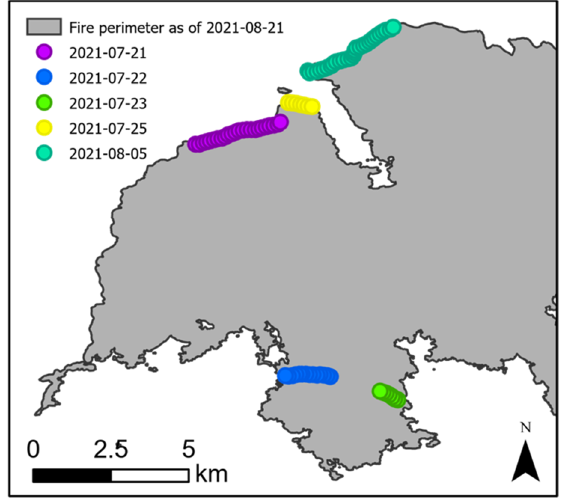
Figure 4. Locations of handline crew nodes (circles), color-coded by date. A Green Ridge fire perimeter from 2021-08-21 is shown for reference. Table 1. Summary of nodes used for Green Ridge fire handlines.